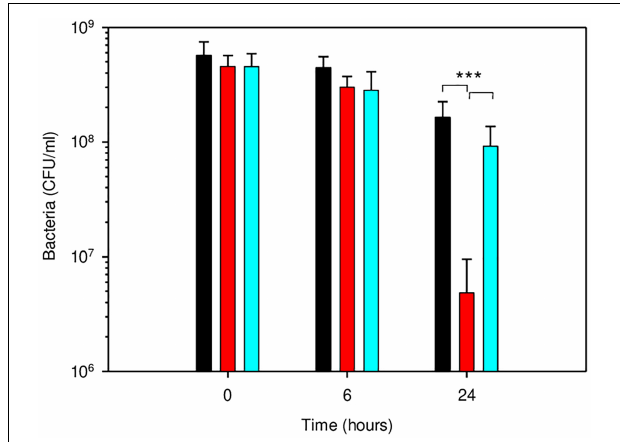
FIGURE 7 | Participation of Dps in survival of B. microti in GMM at pH 4.5. Survival of B. microti wild-type strain (black bars), B. microti (cid:49) dps (red bars), and of B. microti (cid:49) dps complemented with pBBR1- dps (cyan bars). Values are shown as means of 6 experiments ± SD. ***: P <